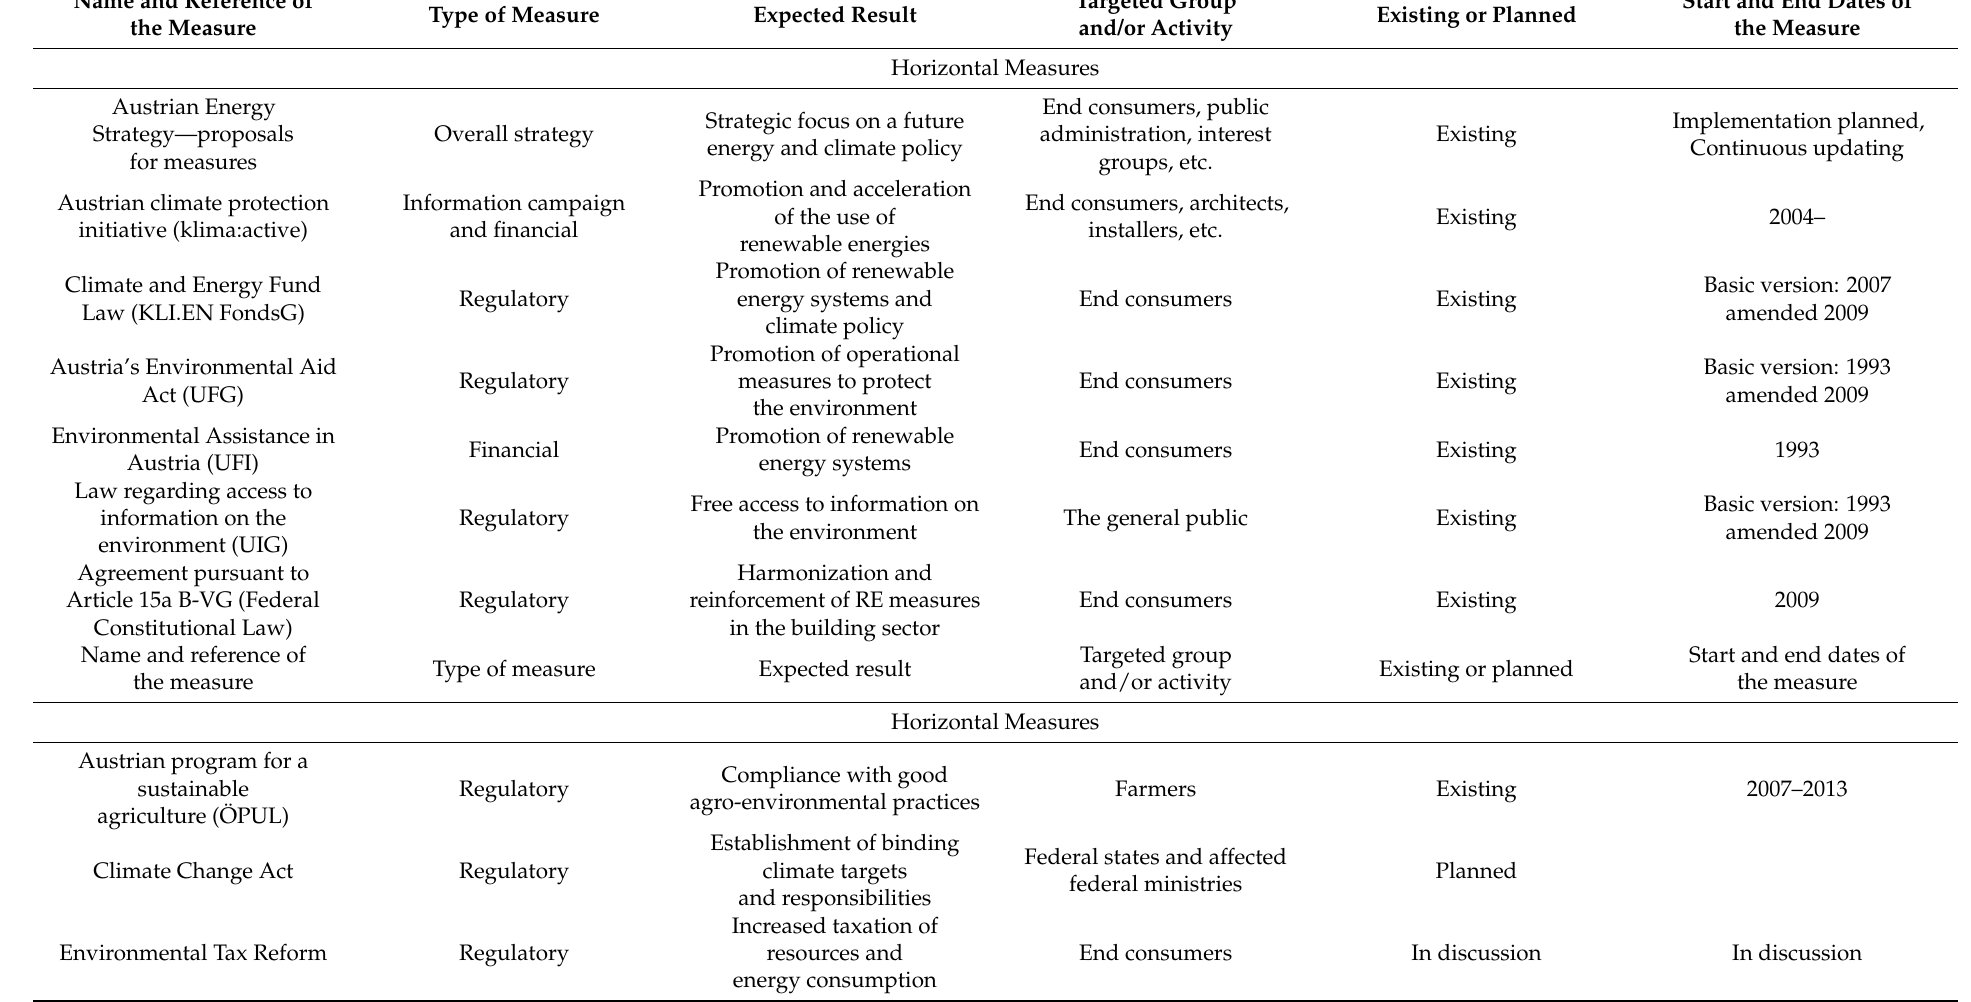
Table 1. Overview of all policies and measures of the National Renewable Energy Action Plan of Austria